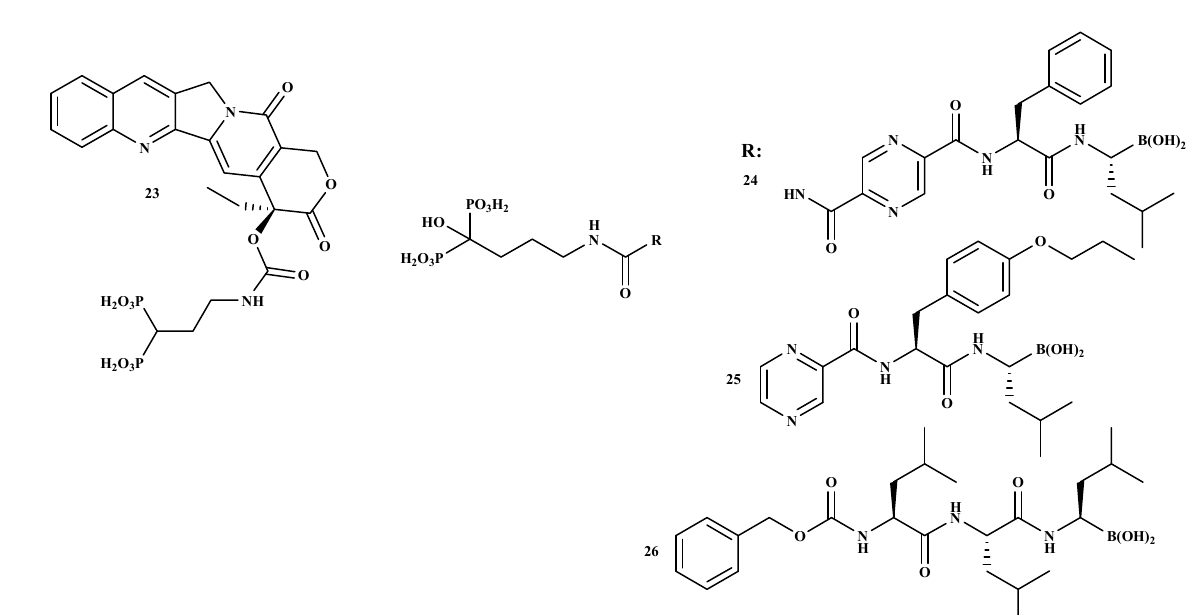
to the results, the compounds are potential bone-targeted agents for the treatment of multiple myeloma.